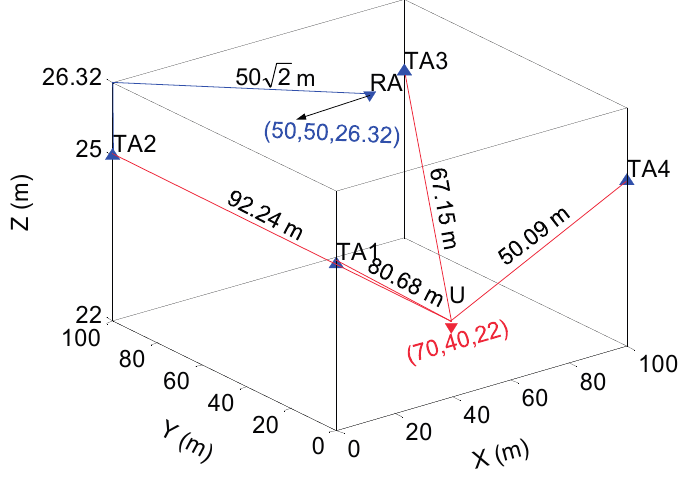
Figure 7. Trace of static